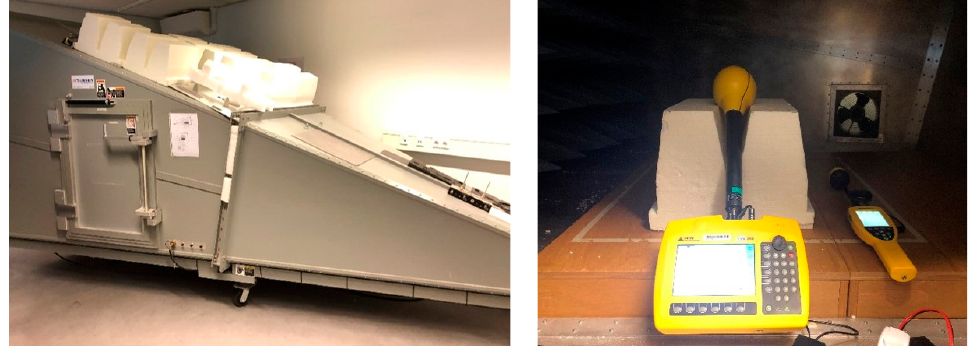
Figure 2. GTEM cell outside and inside. Benchmark equipment (SRM3006) inserted in the GTEM cell. Three scenarios were investigated using the GTEM cell. The SRM3006 was used as a baseline for the GTEM cell measurements, which means that it was also placed inside the